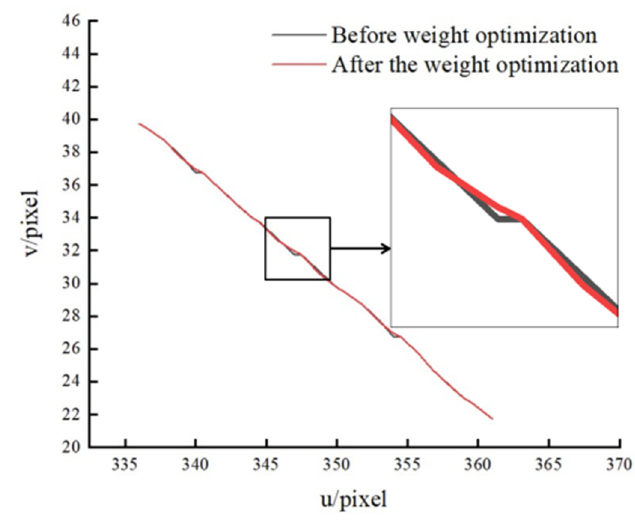
Figure 10. Weight optimization comparison chart.